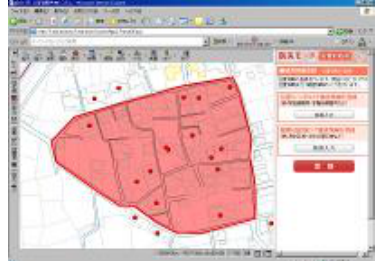
Figure 2. Grasping the number of people in need of care in